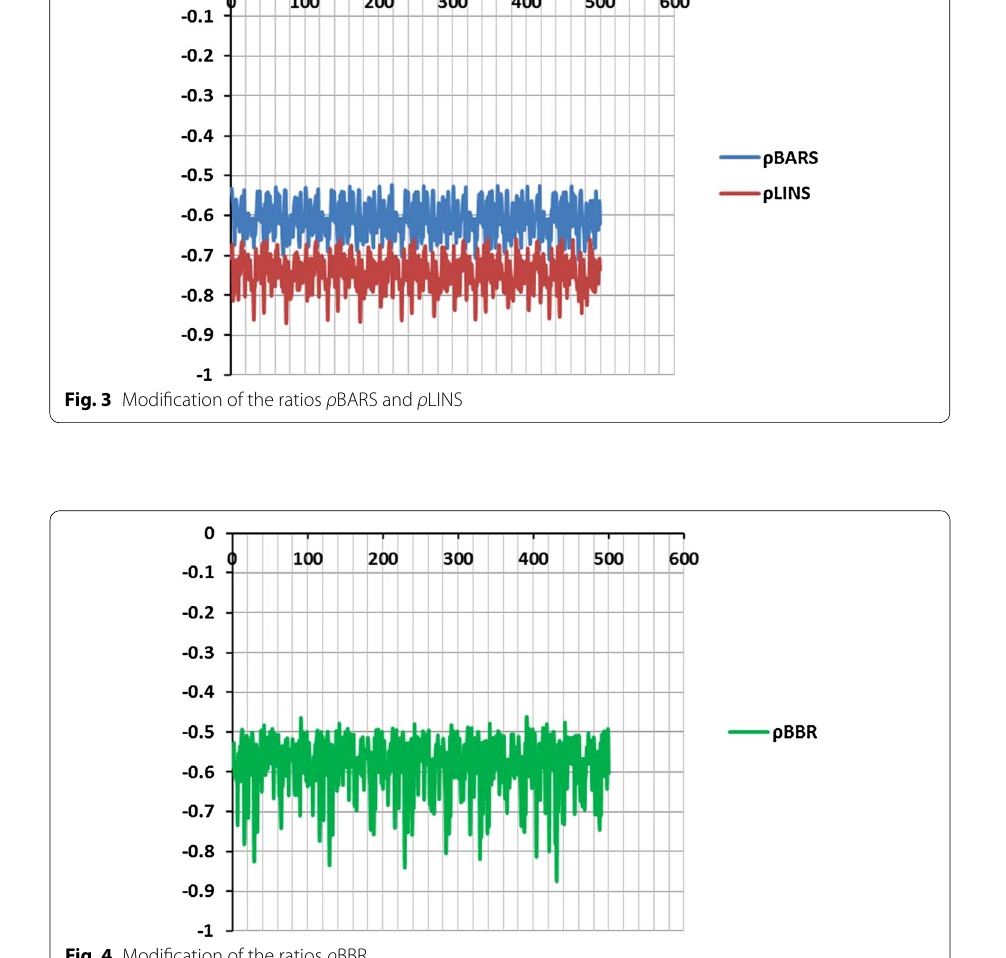
Fig. 4 Modification of the ratios ρ